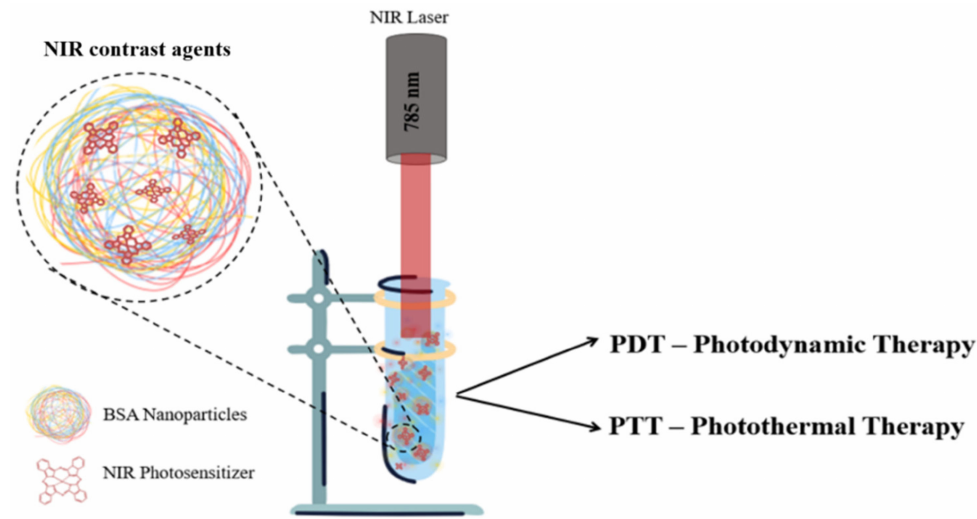
Scheme 2. Illustration of the freshly synthesized NPs’ potential operating as dual therapeutic agents upon irradiation with NIR